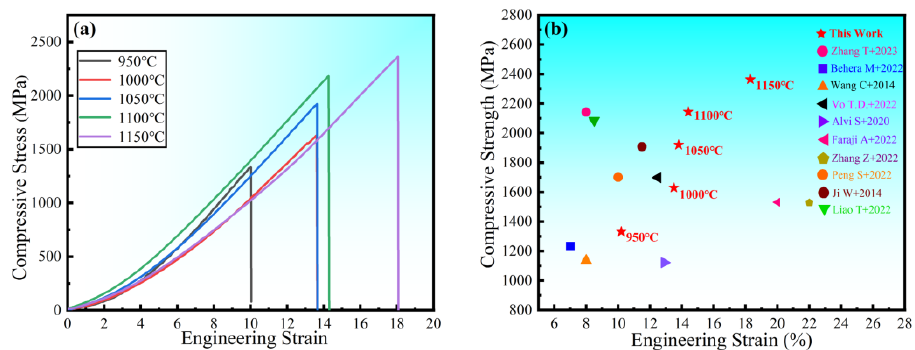
Figure 14. Engineering stress–strain curve of the block under compression ( a ) at room temperature and ( b ) strength compared with other HEAs [27,38 – 46].